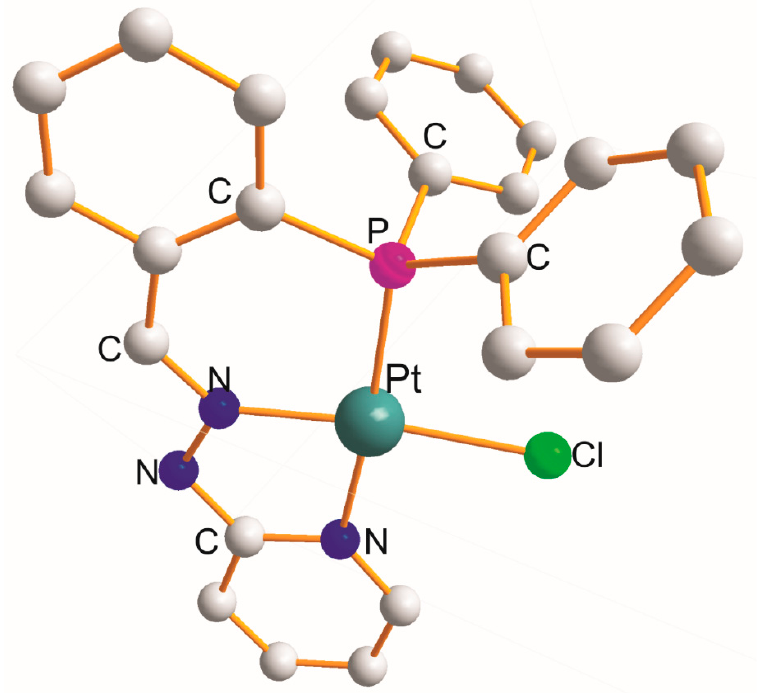
3 –Ph 1 (C 1 )(NC 2 )}(Cl)] 2 P 7 H 6 N 5 H 5 N